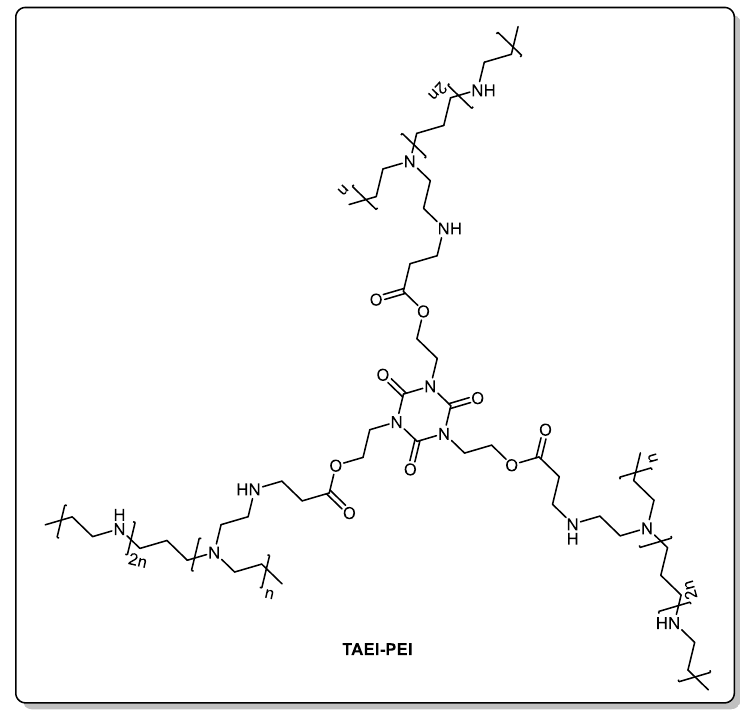
Figure 9. The chemical structure of TAEI-PEI.